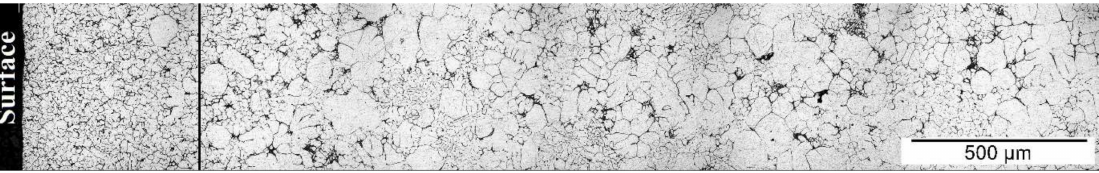
Figure 5. LOM images of cross-sectional view of sample 2.5 RGB.